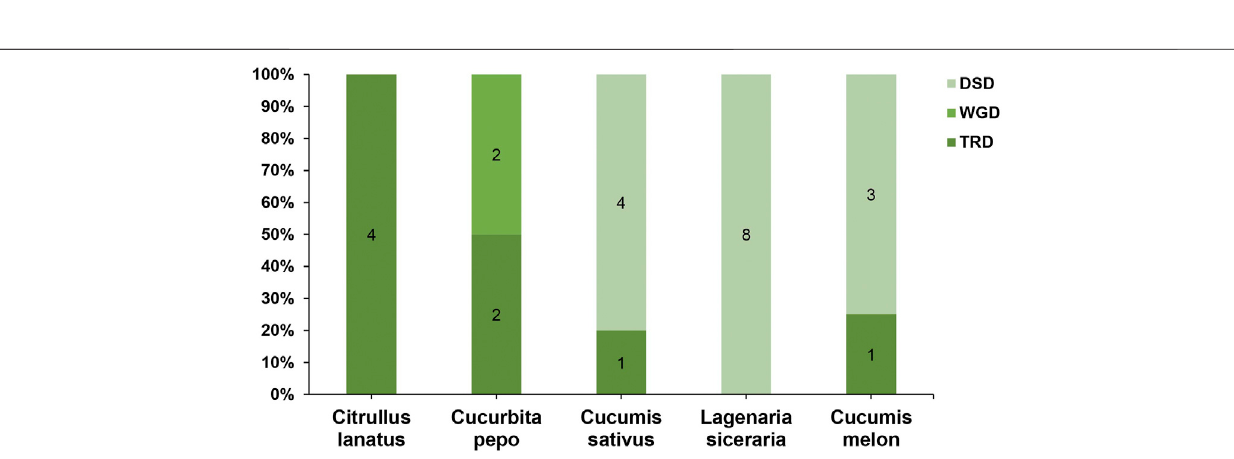
Frontiers in Genetics |